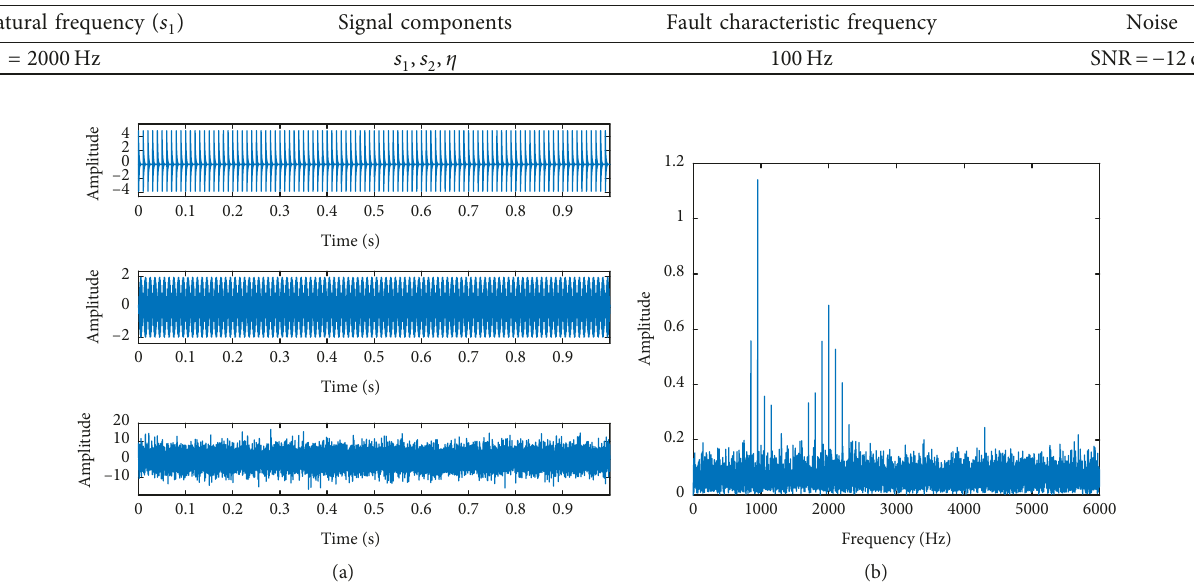
Figure 10: (a) The new impulsive signal s Gaussian noise with SNR